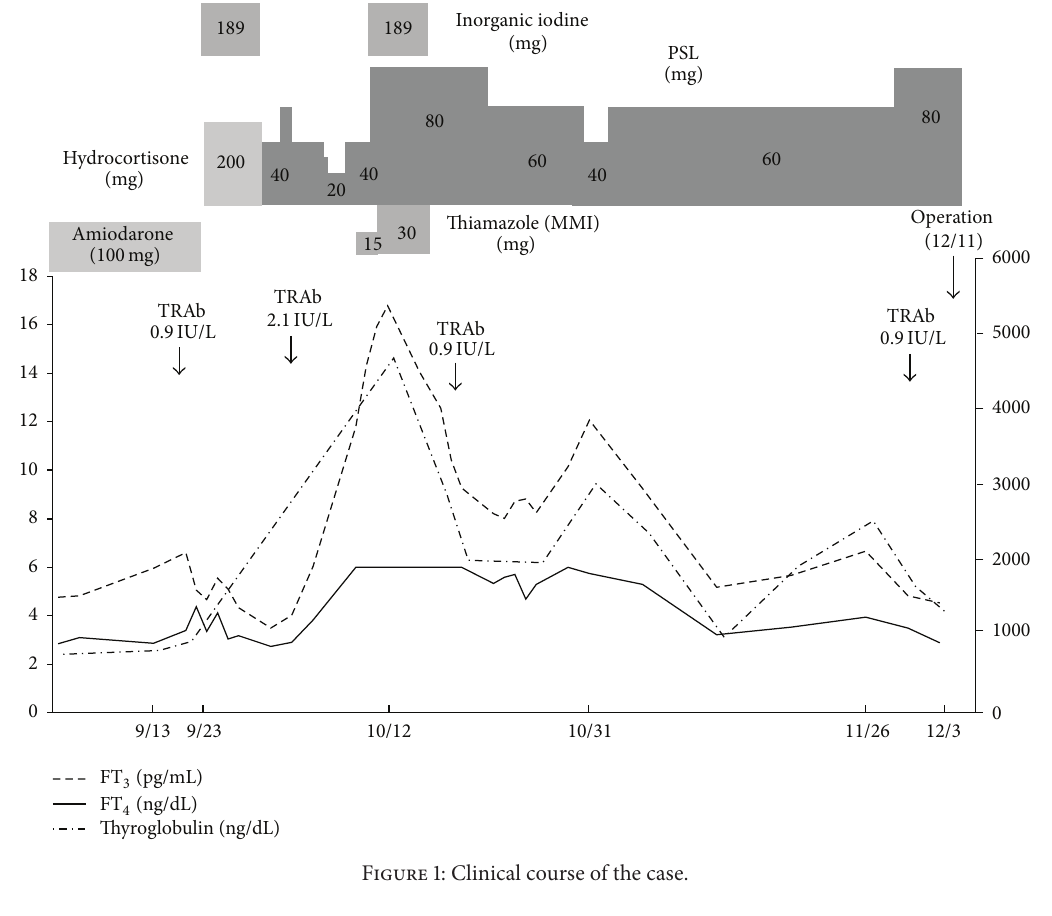
Figure 1: Clinical course of the case.